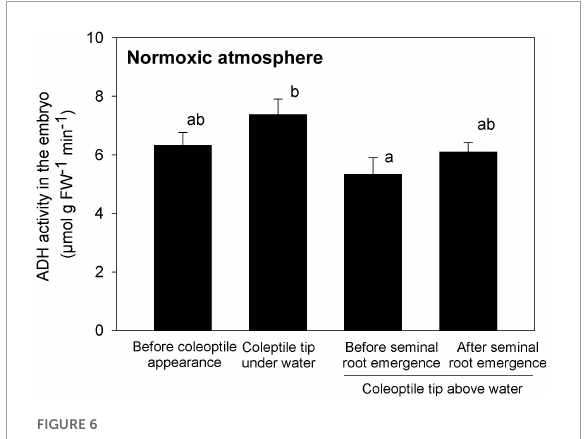
FIGURE6 ADH activity in the embryo during submerged germination below a normoxic atmosphere. Mean ± SE. n = 3 or 4. Different lowercase letters denote significant differences among four different growth phases ( P < 0.05; one-way ANOVA, and then Tukey HSD test for multiple comparisons).